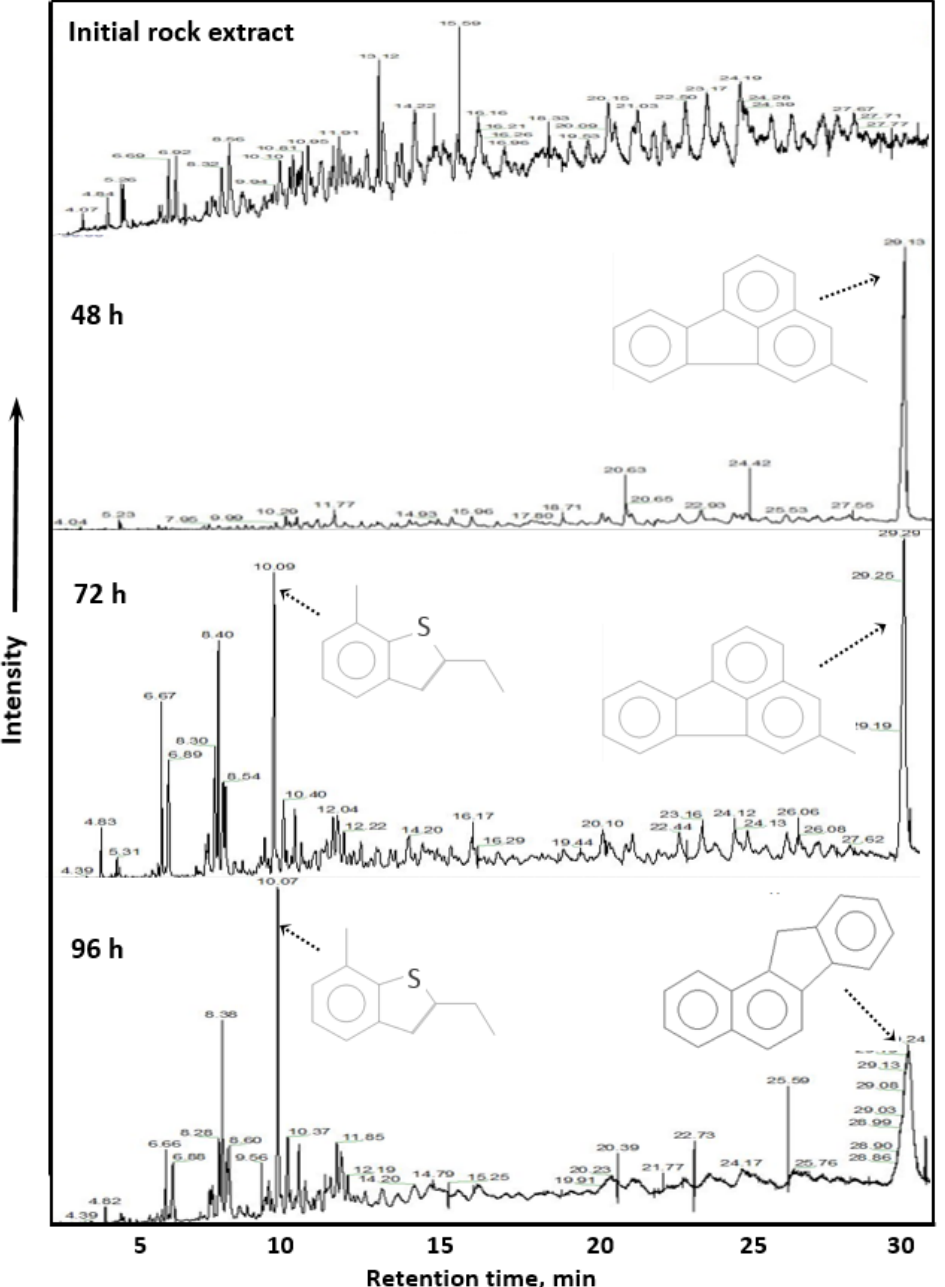
Figure 6. Total ion chromatograms of aromatic hydrocarbons depending on the duration of catalytic aquathermolysis.